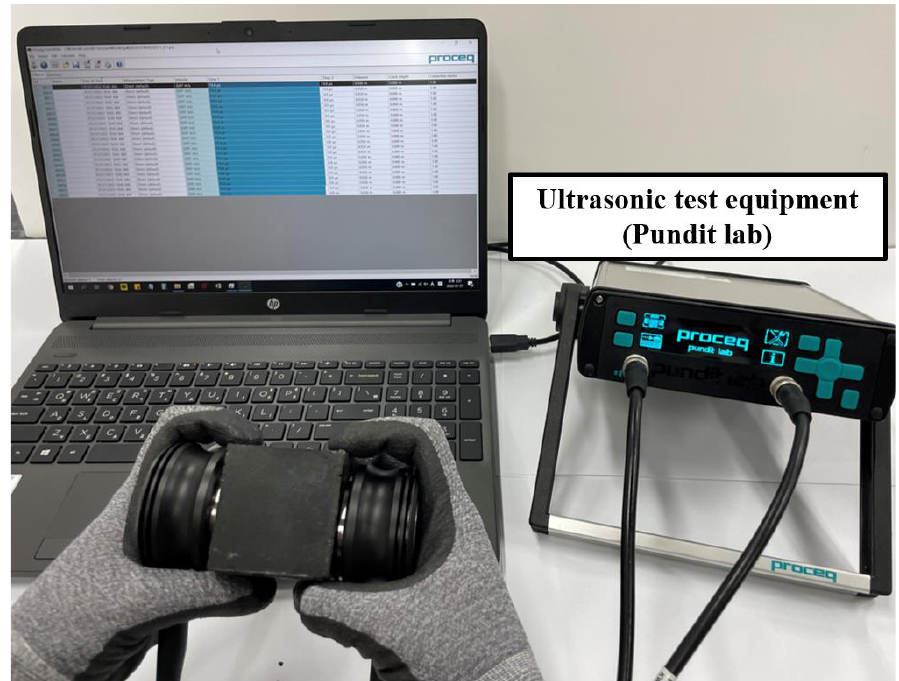
Figure 4. Ultrasonic non-destructive test set-up.